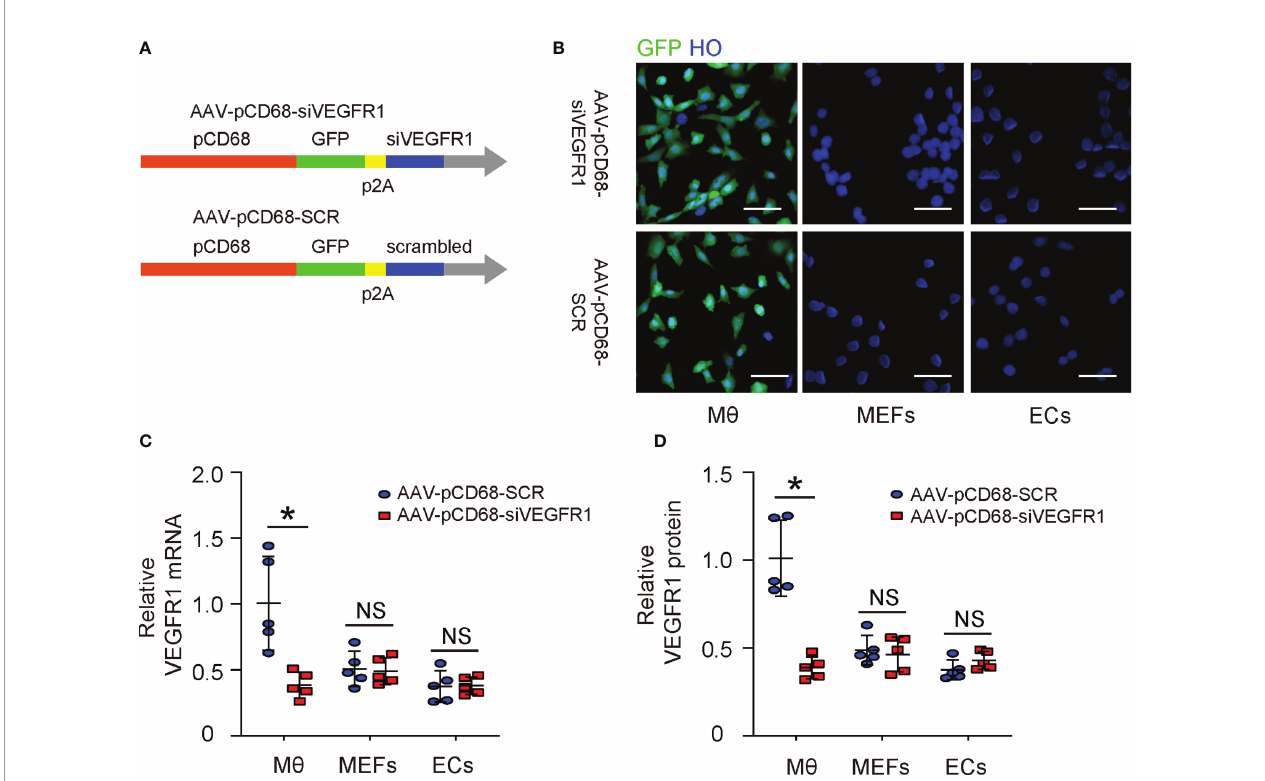
FIGURE 3 | Generation of AAVs that deplete VEGFR1 speci fi cally in macrophages. (A) Schematic of an AAV carrying siRNA for VEGFR1 under a macrophage- speci fi c CD68 promoter (AAV-pCD68-siVEGFR1) and control AAV-pCD68-SCR. (B) Isolated macrophages (M q ), endothelial cells (ECs) and mouse embryonic fi broblasts (MEFs) were infected with AAV-pCD68-siVEGFR1 or control AAV-pCD68-SCR, shown by representative immuno fl uorescent images. (C, D) RT-qPCR (C) and ELISA (D) for VEGFR1 in infected M q , ECs and MEFs. *p < 0.05. NS, non-signi fi cant. Scale bars are 20